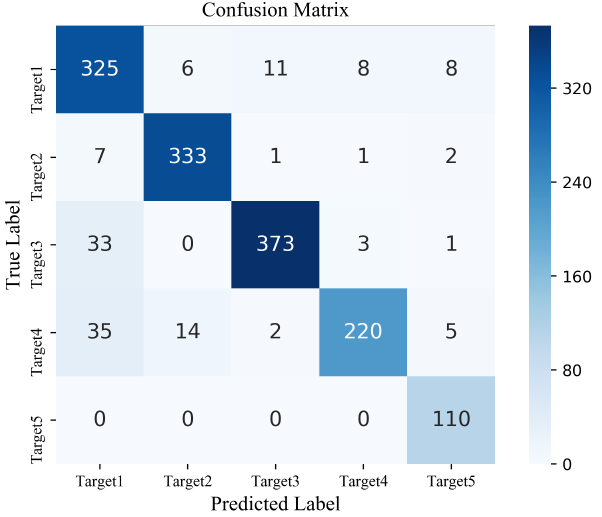
Figure 10. The confusion matrix with data augmentation.